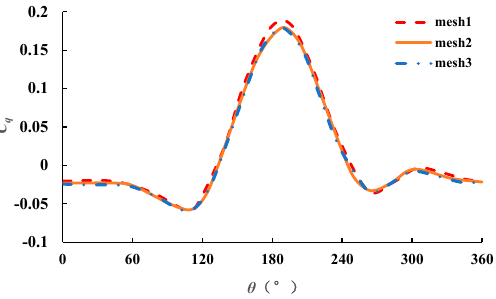
Figure 6. Variation trend of torque coefficient of single turbine with phase angle for three different meshes.